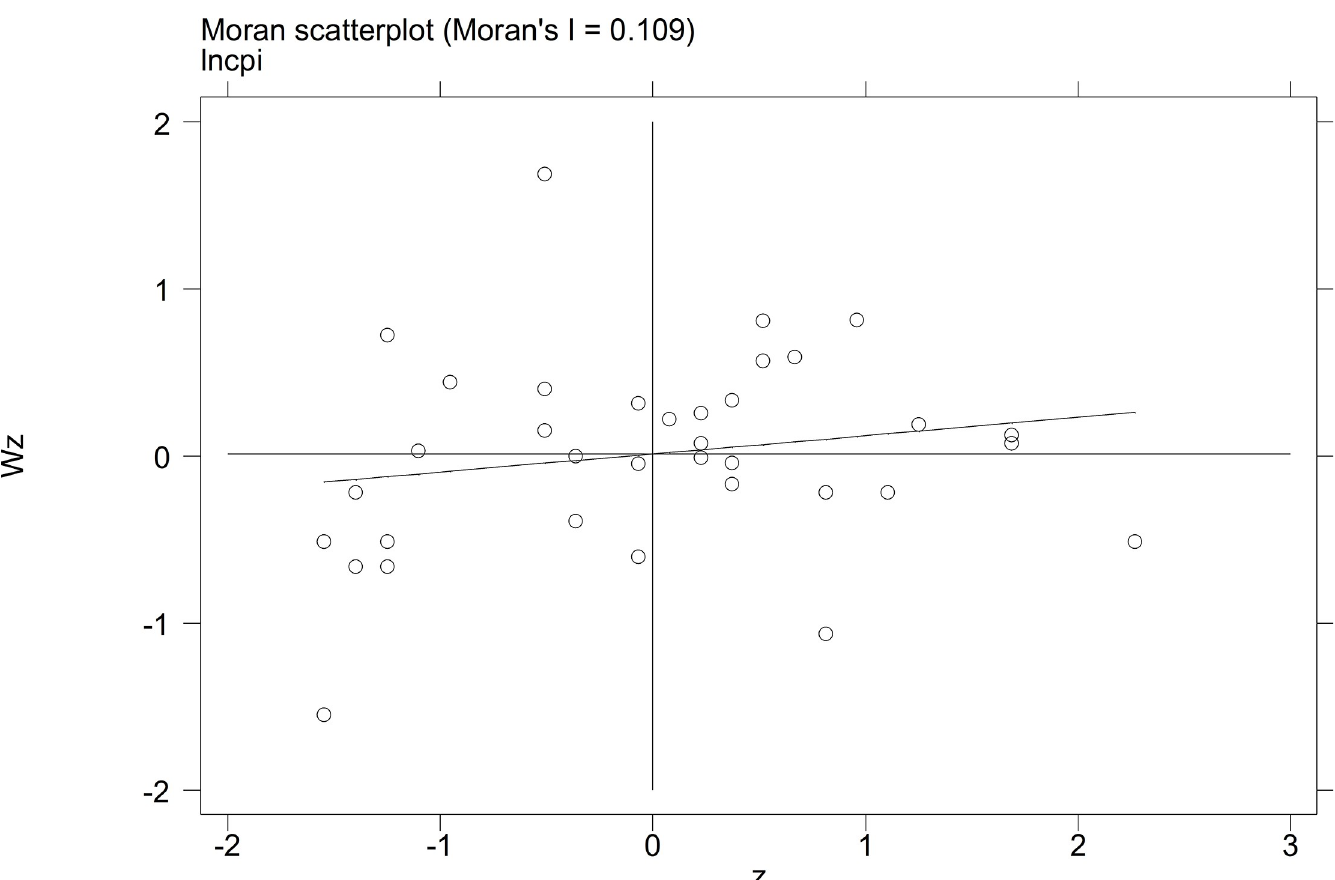
Fig 5. Scatterplot of Moran’ I for CPI in